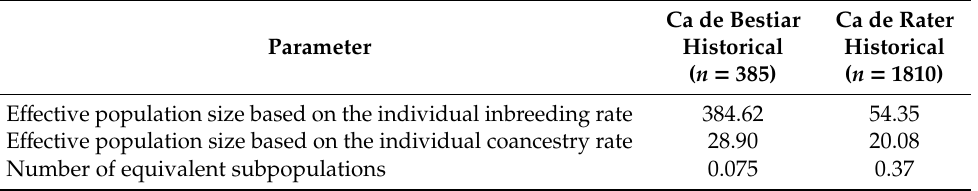
Table 4. Statistical results for e ff ective population size calculated on the basis of the individual inbreeding rate, the individual coancestry rate, and the number of equivalent